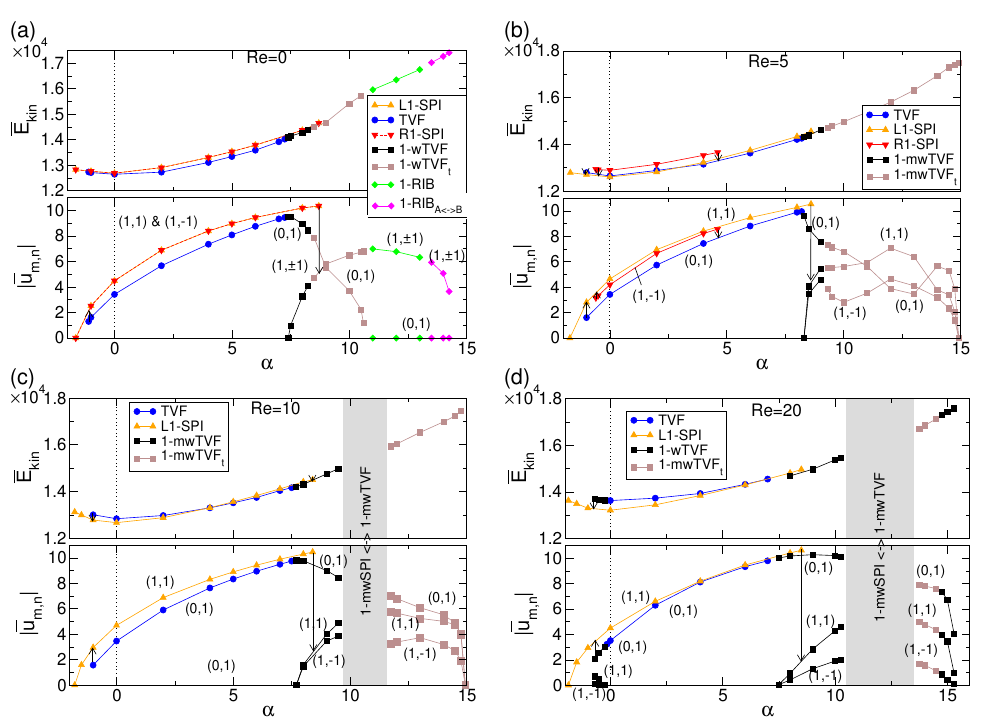
Figure 3. Bifurcation diagrams for various vortex structures versus α for ( a ) Re = 0, ( b ) Re = 5, ( c ) Re = 10, and ( d ) Re = 20. Shown are top (time-averaged) modal kinetic energy E kin (Equation (11)) and bottom the dominant (time-averaged) radial flow field amplitudes | u m , n | at mid-gap con- tributed from the modes ( m , n ) as indicated. Vertical arrows indicate the transition when one flow becomes